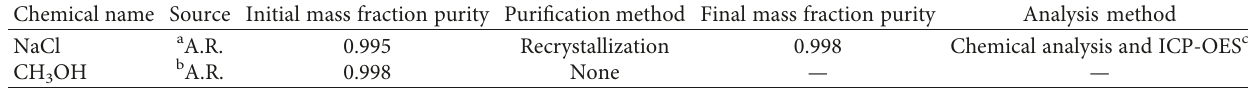
Table 1: Chemicals used in this study.